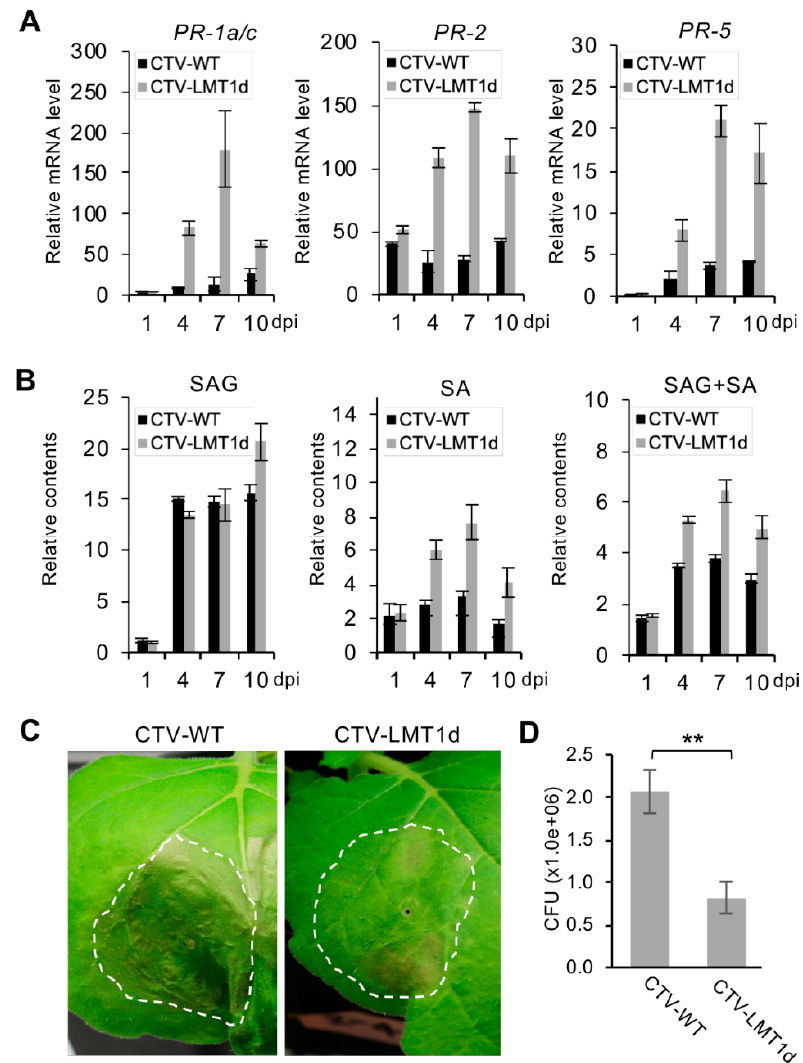
Figure 4. Comparison of SA-mediated defense response in the N. benthamiana leaves infiltrated with pCTV-WT and pCTV-LMT1d at 1, 4, 7 and 10 dpi. ( A ) Relative mRNA levels of PR-1a/c , PR-2 , and PR-5 genes. ( B ) Relative contents of salicylic acid (SA) and glucose-conjugated SA (SAG). Black bar, pCTV-WT; grey bar, pCTV-LMT1d. Each bar represents a mean value +/- standard error of the mean ( n = 3) within a set of samples consisting of one leaf disc per plant from three plants infiltrated with each virus variant. For each repeat, three RT-qPCR determinations were made. Three repeat experiments showed similar results. ( C ) Symptoms of P. syringae in N. benthamiana plants. Plants pre-infiltrated with a virus construct were challenged with P. syringae at 7 dpi and assayed at 4 days after the challenge. ( D ) Titers (colony-forming units (CFU) per leaf disc) of P. syringae in the leaves shown in ( C ). Each bar represents a mean value +/- standard error of the mean ( n = 9) within a set of samples consisting of one leaf disc per plant from three plants infiltrated with each treatment collected from three independent replicates. Statistically significant differences determined by Student’s t -test, p < 0.01, were denoted by asterisk (**).